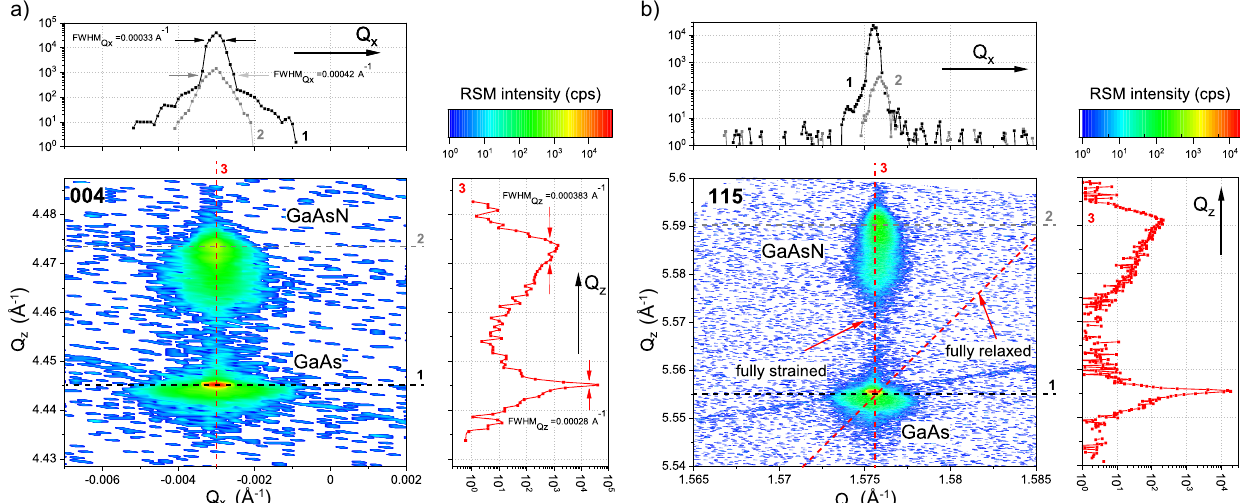
Figure 6. Reciprocal lattice maps of GaAsN solar cell: ( a ) for symmetrical (004) reflection, ( b ) for asymmetrical (115) reflection. The profiles across lines numbered as 1, 2 and 3 in RLMs are shown in the